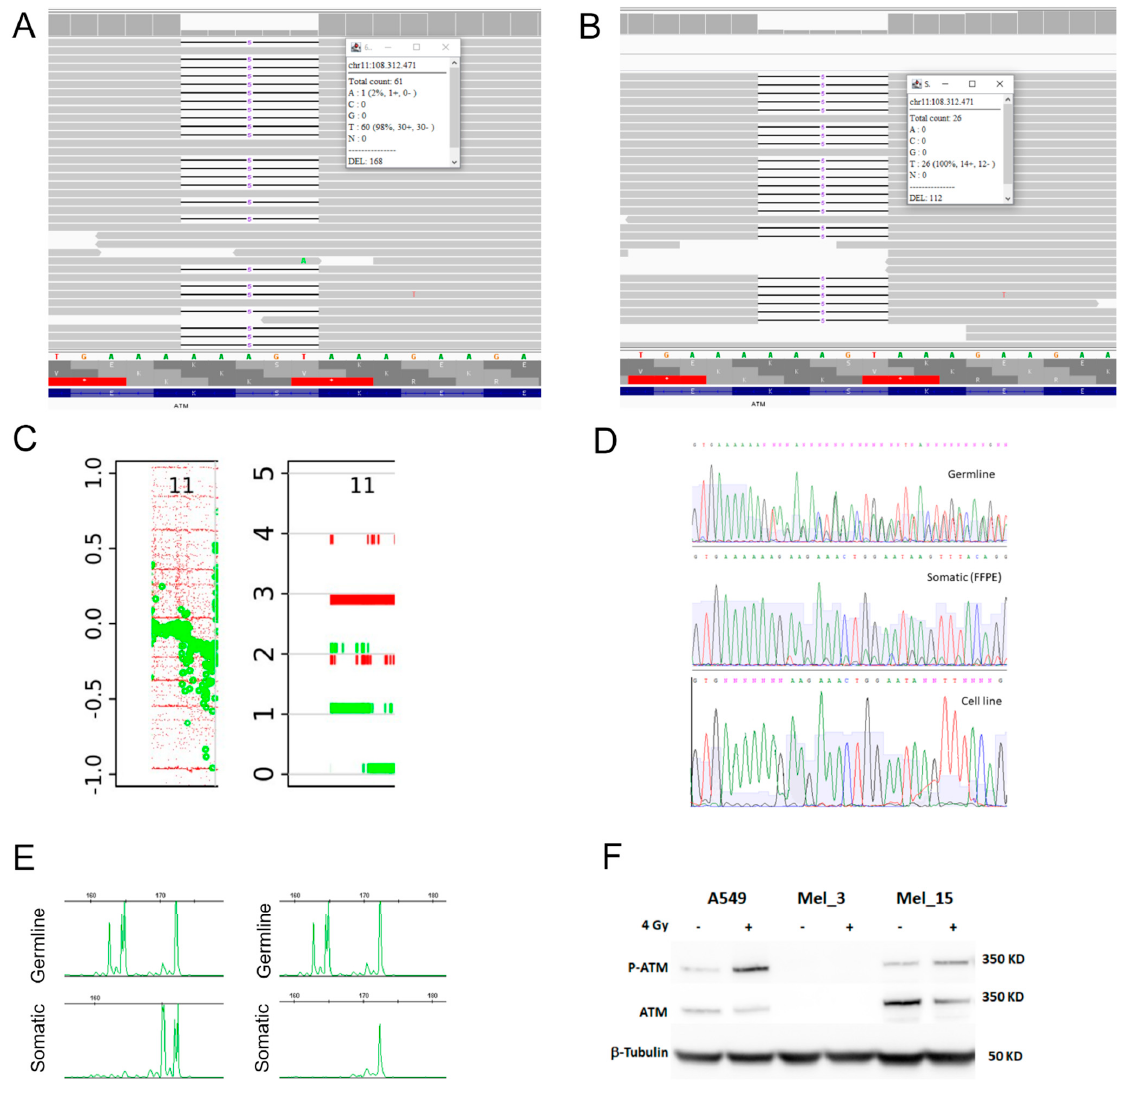
Figure 3. Multiple assays showing loss of heterozygosity of the ATM p.Ser1993ArgfsTer23 PV in Mel_3. ( A ) WES showing prevalence of the mutant allele (c.5979_5983del), with an AF of 74%. ( B ) RNA sequencing showing a mutant allele (c.5979_5983del) with a frequency of 94%. ( C ) The LogR plot (left) derived from WES analysis shows the presence of CNV: a region on chromosome 11q that encompasses the ATM gene (chr11: 100650080-115623321) shows copy-number loss; in the ploidy plot (right), the same region of the tetraploid sample contains three copies of a single allele (red bar), whereas the other allele is deleted (green bar). ( D ) Sanger sequencing showing the heterozygous germline allele (top), partial loss of the WT allele (middle) in the FFPE sample, and the complete loss of the WT allele in the patient’s derived melanoma cell line (bottom). ( E ) Microsatellite analysis showing LOH in one of the FFPE samples and in the patient’s derived melanoma cell line: D11S2179 LOH in tumor is determined by comparing the peak-height ratio of blood sample (top) with those of tumor (bottom left) and cell line (bottom right) DNA. ( F ) Western blotting. ATM protein expression was tested on A549, a NSCLC cell line expressing functional ATM, and on two primary cell lines derived from metastatic cutaneous melanoma biopsies, Mel_3 and Mel_15. A549 and Mel_15 cells express ATM and upmodulate the expression of its phosphorylated form upon irradiation at 4 Gray. Conversely, the Mel_3 cell line does not express either ATM or p-ATM. Cropped images are obtained from the same blot subsequently probed with the different antibodies. Molecular weight markers are shown. Abbreviations: AF = Allele Frequency. FFPE = formalin fixed paraffin